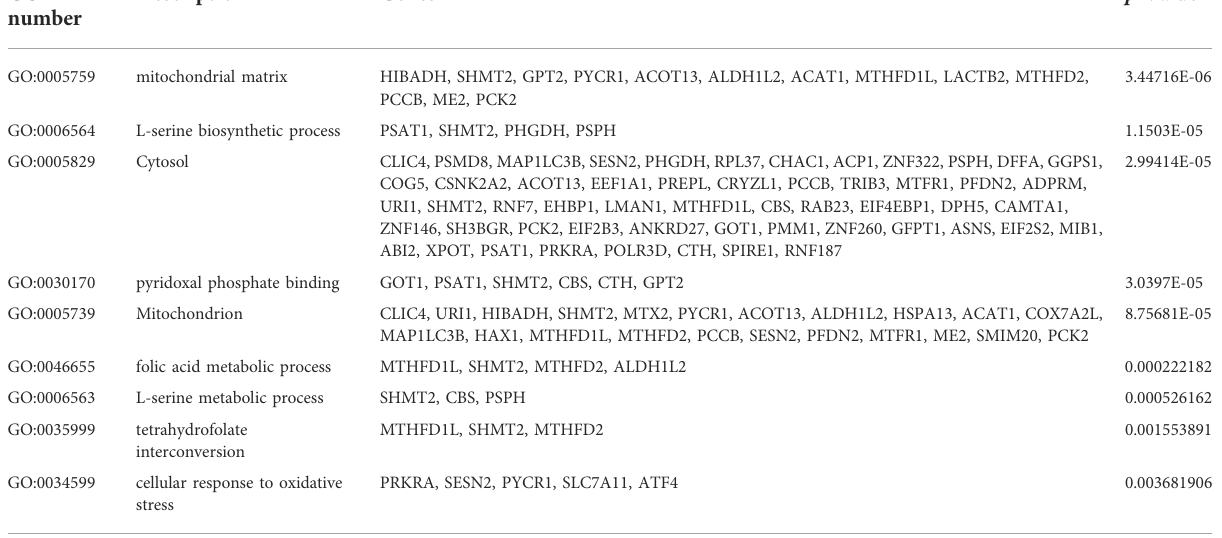
TABLE 4 Gene ontology analysis of LINC00662-related genes.